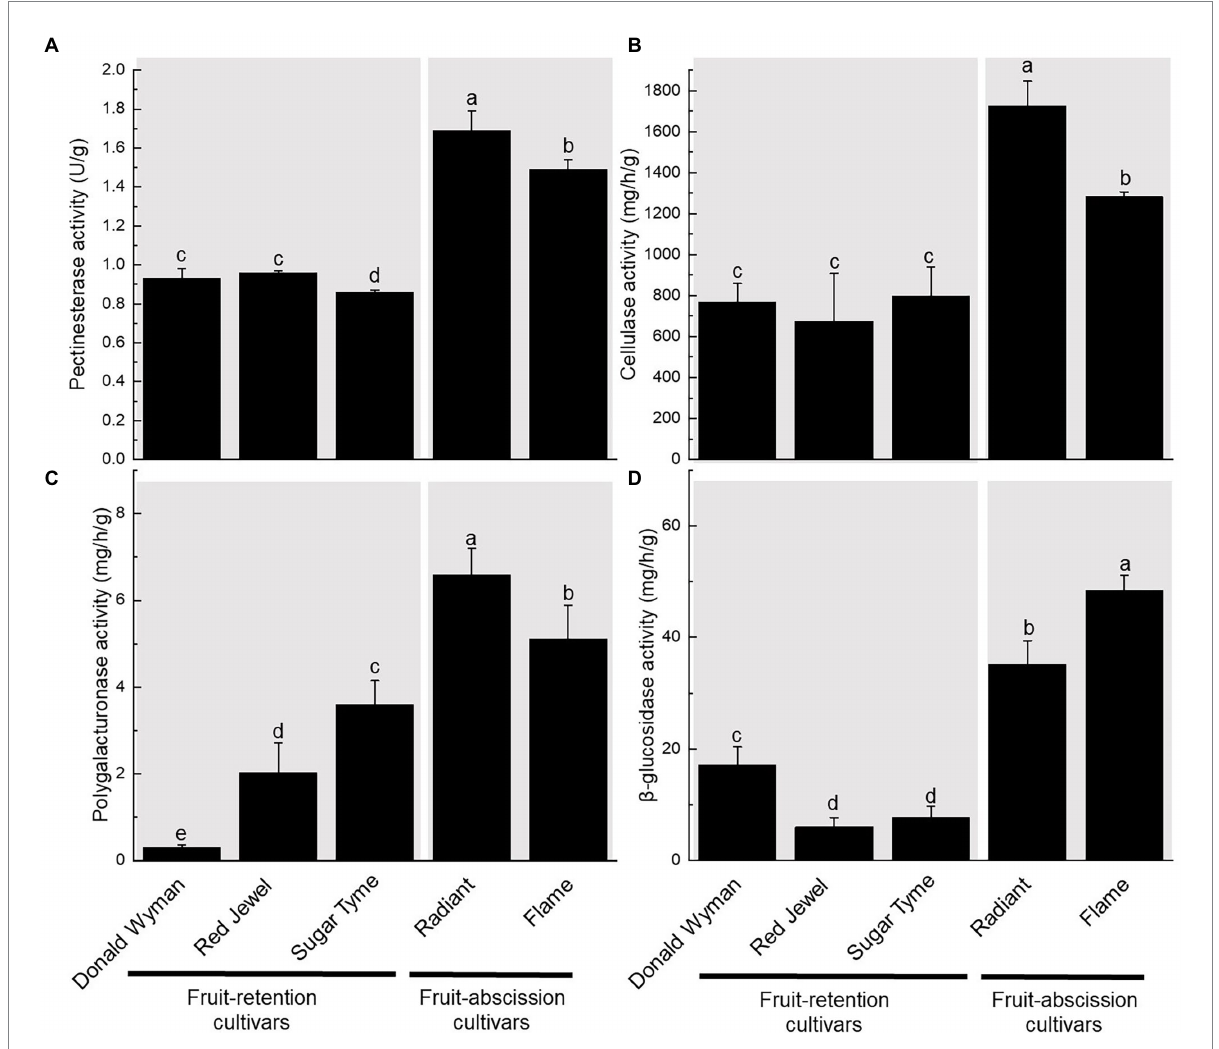
FIGURE 2 Variation in enzyme activity of fruit pedicels in fruit-retention and -abscission cultivars of ornamental crabapple. (A) Pectinesterase (PE); (B) Cellulase (CX); (C) Polygalacturonase (PG); and (D) β -glucosidase (BG). Different letters indicate significant differences at p <